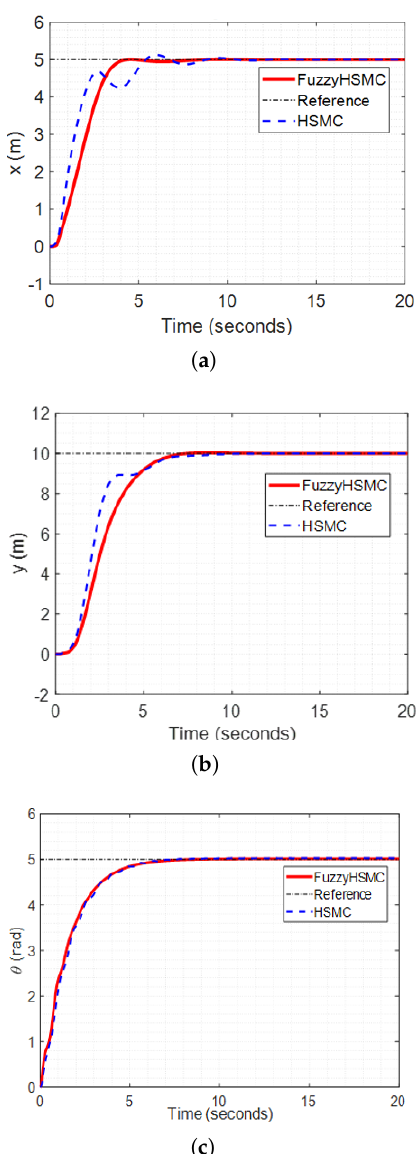
Figure 4. The actuated states given the constant input. ( a ) The trolley position x ( t ) . ( b ) The bridge position y ( t ) . ( c ) The pulley angle θ ( t )